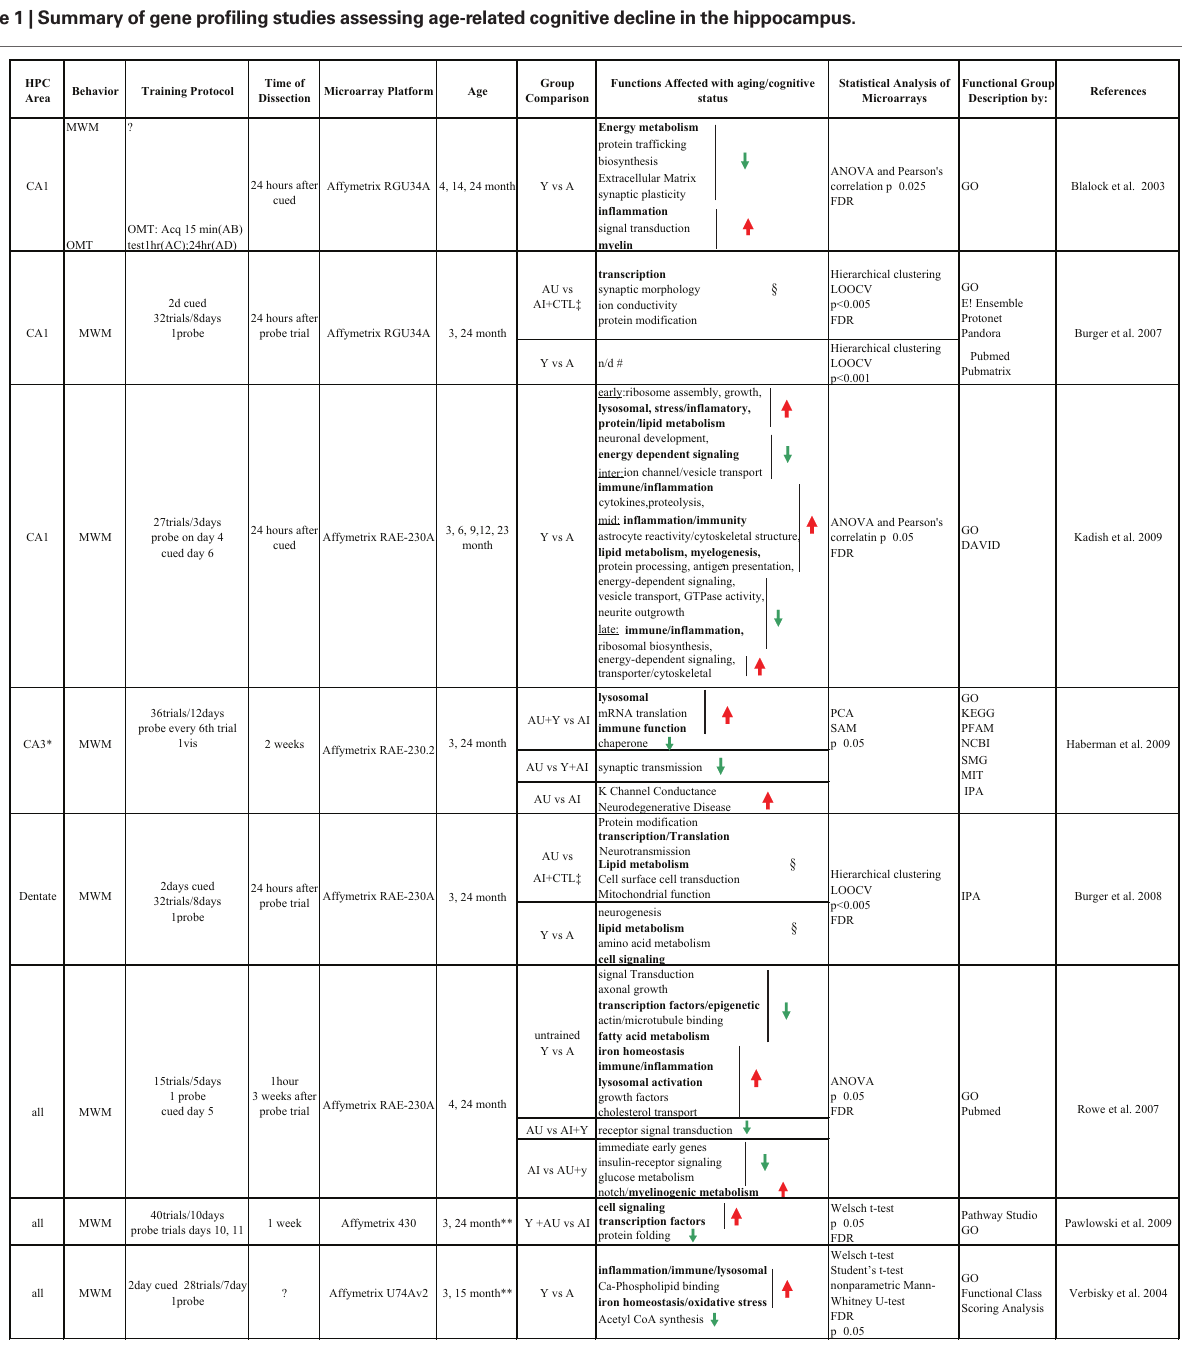
Table 1 | Summary of gene profiling studies assessing age-related cognitive decline in the hippocampus.